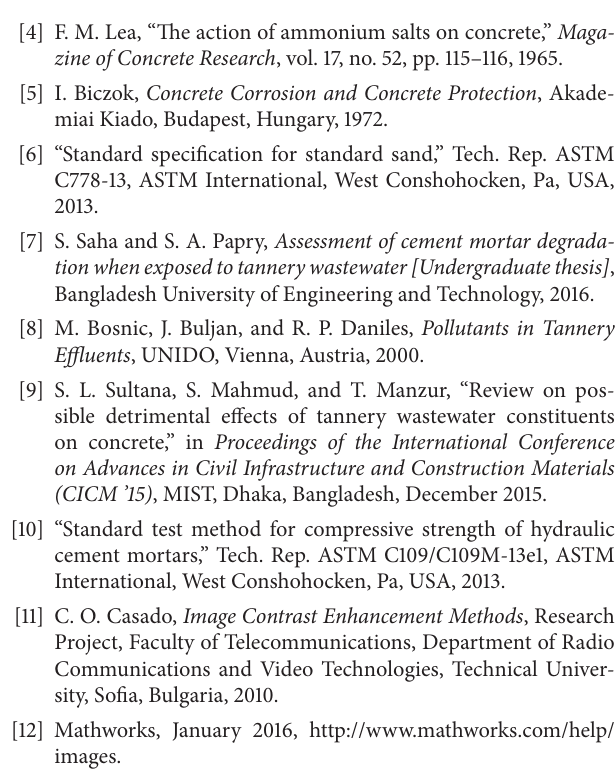
surface area loss, weight loss, and strength loss to explore the correlation more